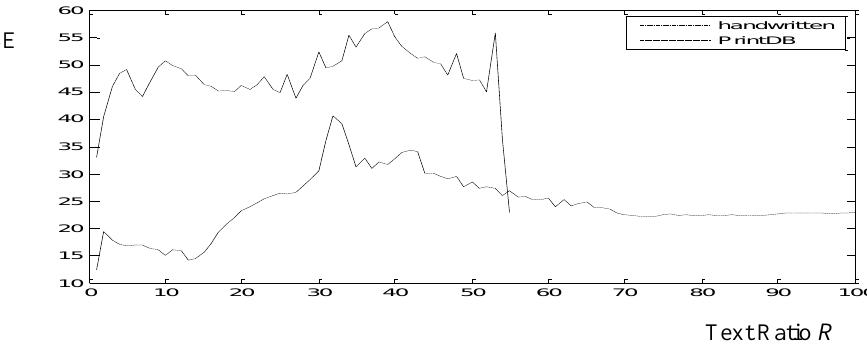
Figure 10. Sum of square errors according to text ratio R for the printed db (dotted line) and the three handwritten databases (broken line).